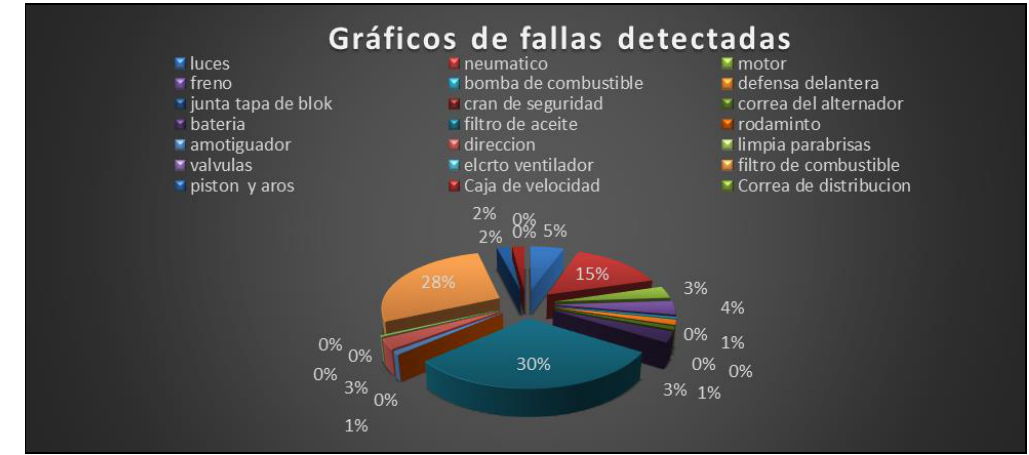
Figura 2: Promedio de disponibilidad por línea. Fuente: Los autores, (2018).